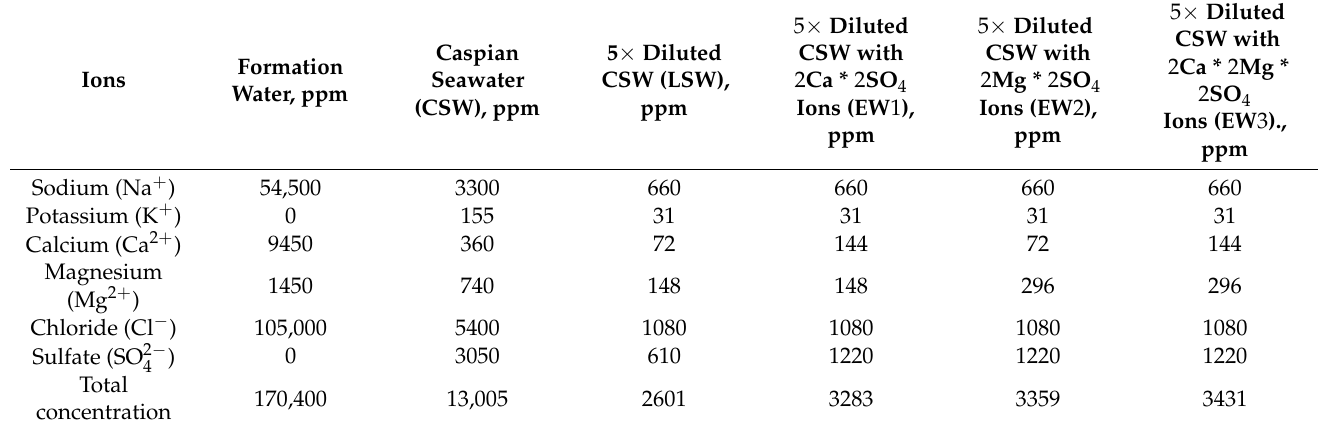
Table 3. Composition of formation water, seawater, LSW, and EW